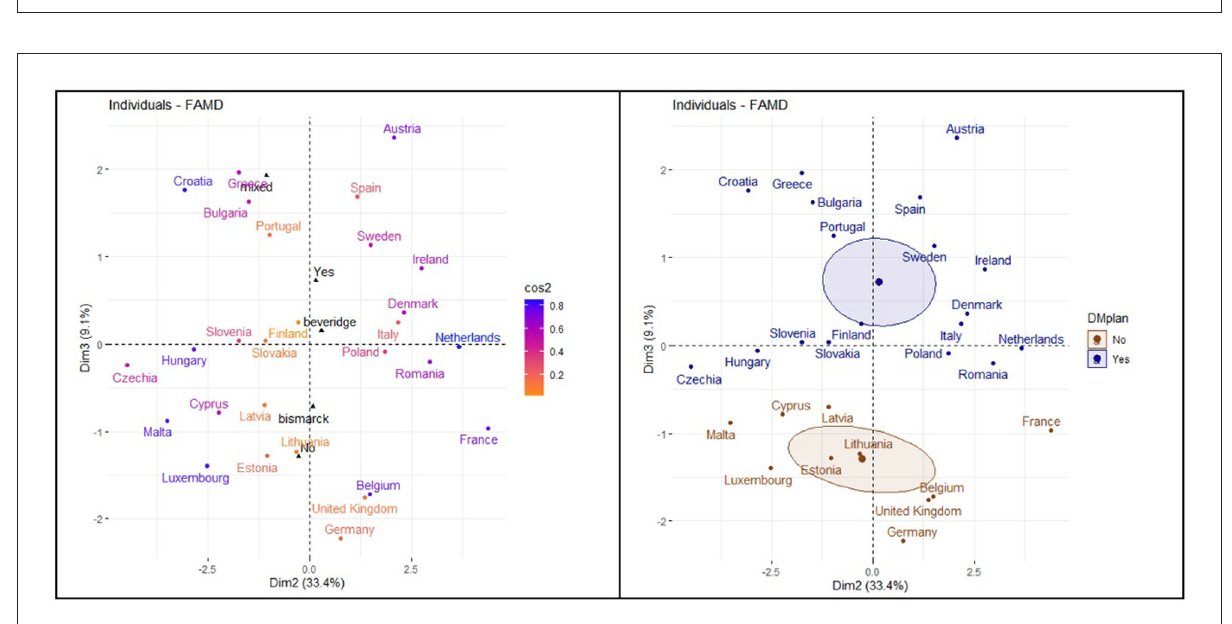
FIGURE11 Distribution of the countries in dimension 2 and dimension 3.